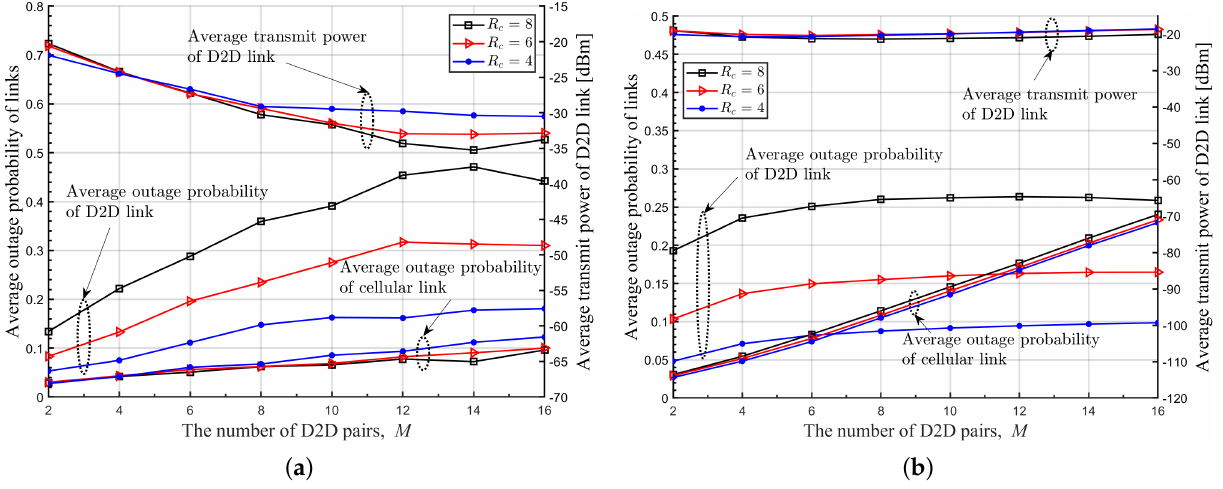
Figure 11. Average outage probabilities of cellular and D2D links and average transmit power of DUET with respect to M for various R c , where ¯ r c = 200 [m]. ( a ) Proposed DRL-based RA, ( b ) Greedy